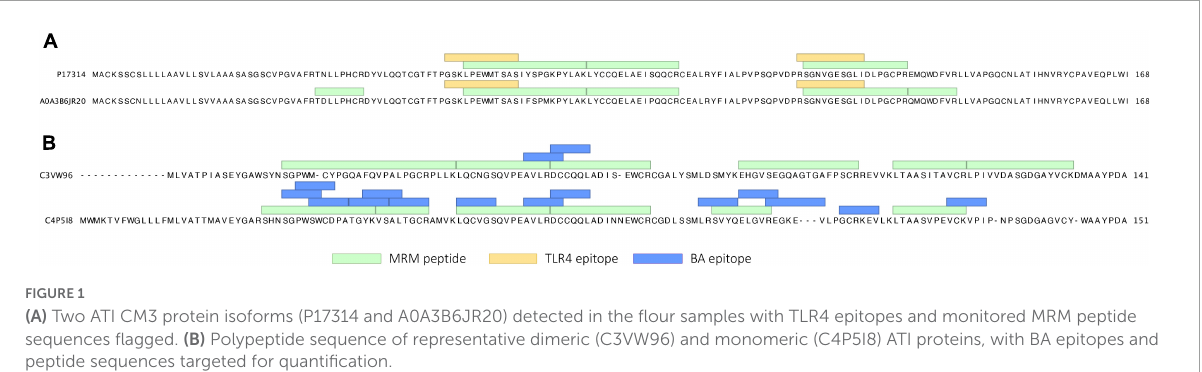
FIGURE1 (A) Two ATI CM3 protein isoforms (P17314 and A0A3B6JR20) detected in the flour samples with TLR4 epitopes and monitored MRM peptide sequences flagged. (B) Polypeptide sequence of representative dimeric (C3VW96) and monomeric (C4P5I8) ATI proteins, with BA epitopes and peptide sequences targeted for quantification.